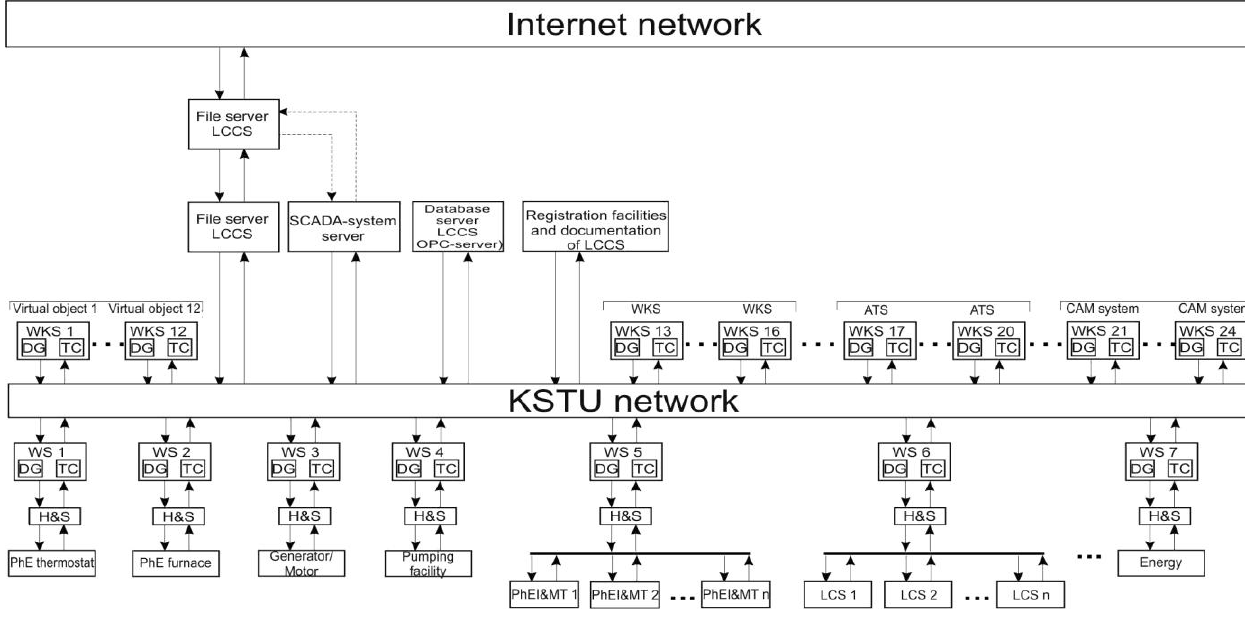
Figure 1. Functional-structural scheme of